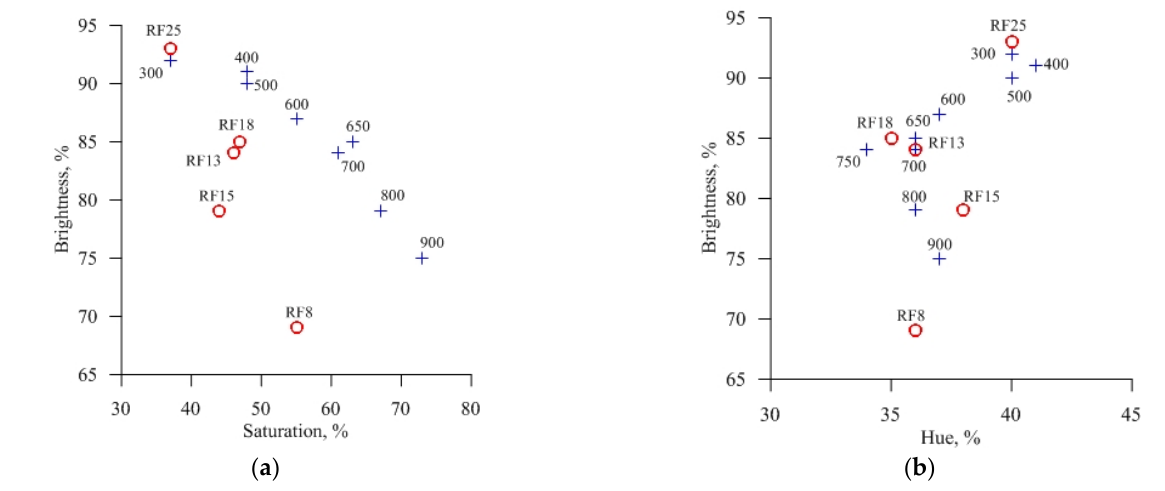
Figure 7. Values of the HSB color model parameters—brightness, saturation ( a ), and brightness, hue ( b ) of the MF (+) and RF (o) samples.